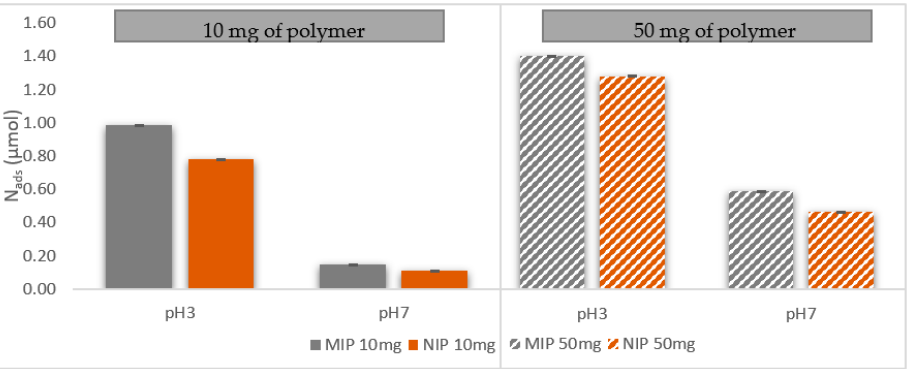
Figure 3. pH effect on the quantity of caffeic acid adsorbed (N ads ) by CA MIP using cyclic voltammetry in a PBS 0.05 M/EtOH (90/10, v / v ) solution containing 1.11 mM of CA, in the presence 10 mg (left) and 50 mg (right) of CA-MIPCA and NIP.